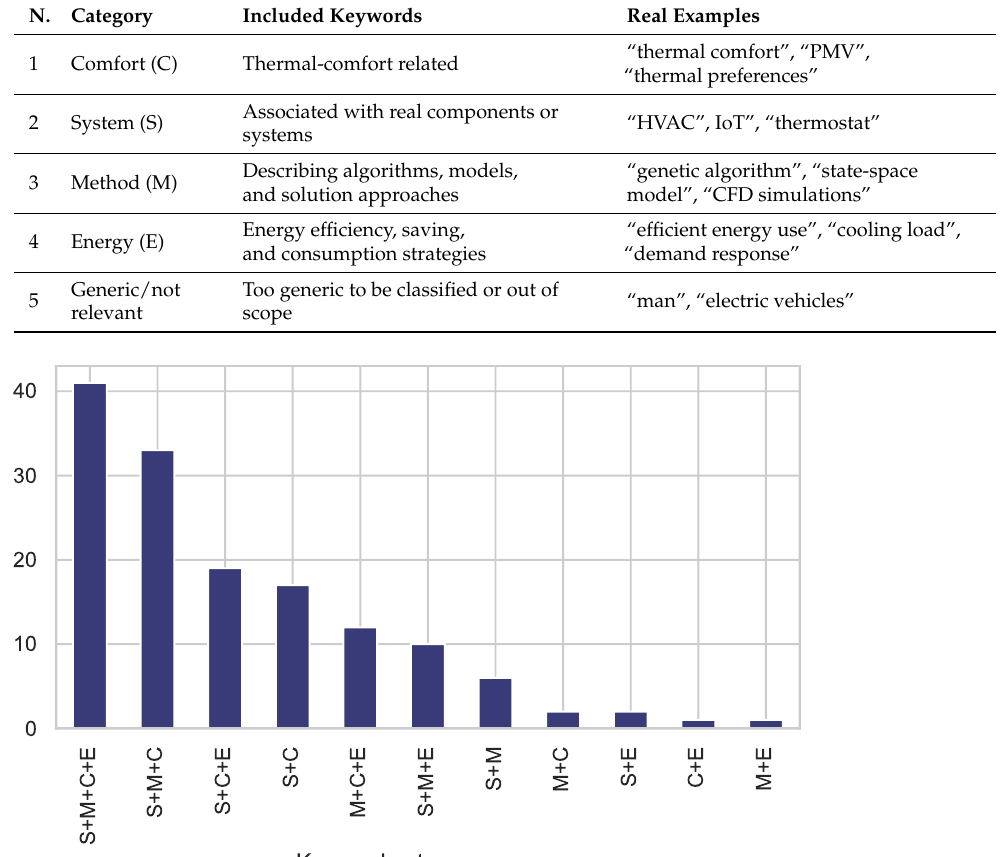
Figure 6. Number of papers containing at least one keyword for the identified semantic